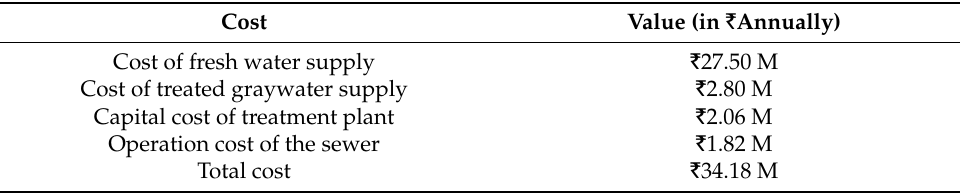
Table 7. Cost split up for implementation of local on-site graywater reuse: IIT Madras network.